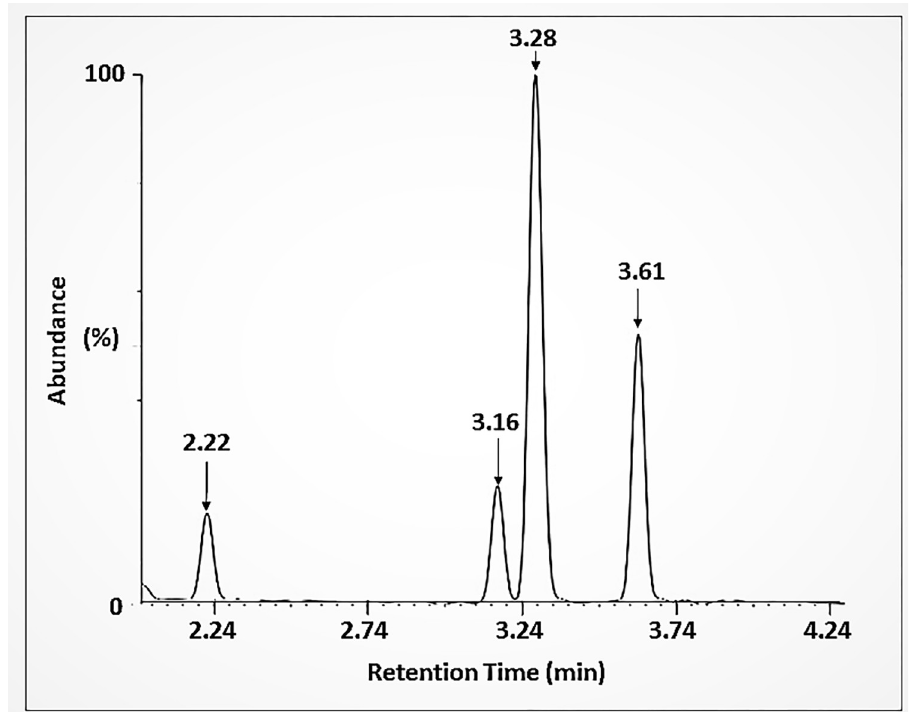
Fig 5. GC-MS chromatogram. Shows methanol extract of NSS with 4 major peaks at specific retention times (RT) that correspond to different components i.e., ethylenimine (2.22 min), ethylbenzene (3.16 min), 1;2-Diphenylamine (3.28 min) and o-xylene (3.61 min),